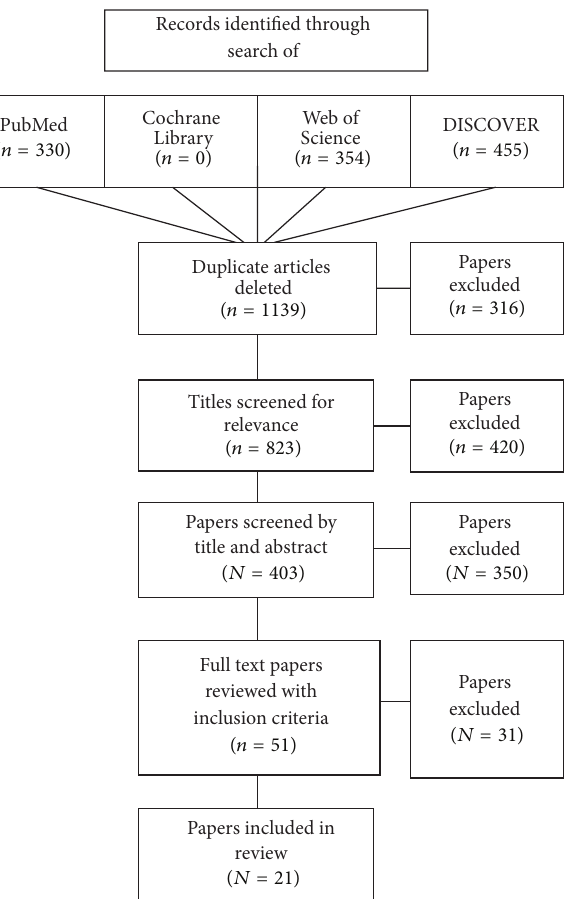
Figure 1: Flow chart of paper selection and